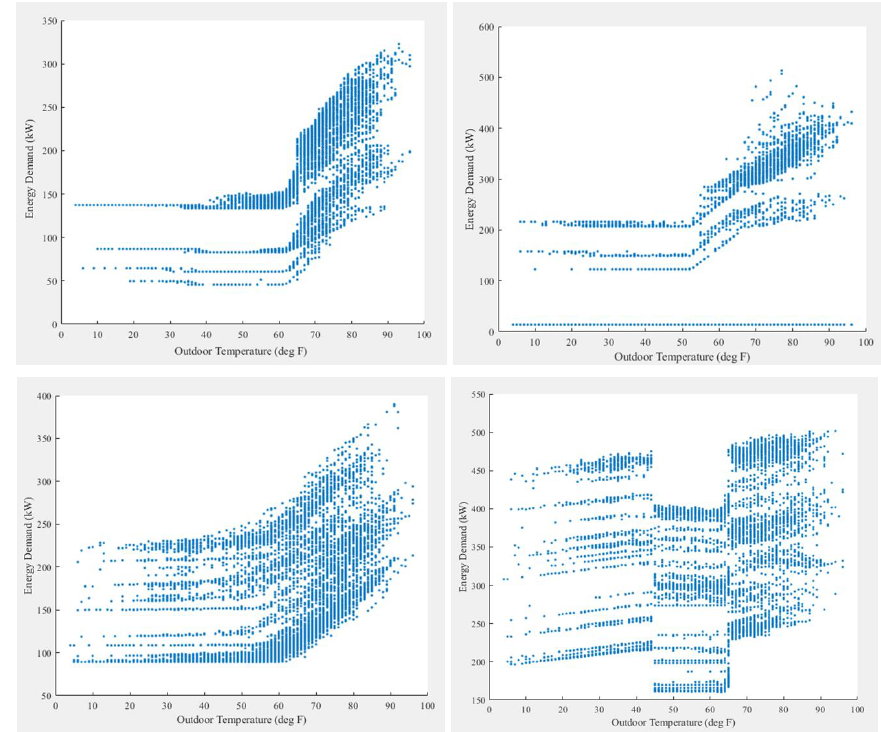
Figure 2. Energy consumption in Buildings 1 and 2 ( above ), Buildings 3 and 4 ( below ) with respect to outdoor dry bulb temperature in Greensboro, NC.